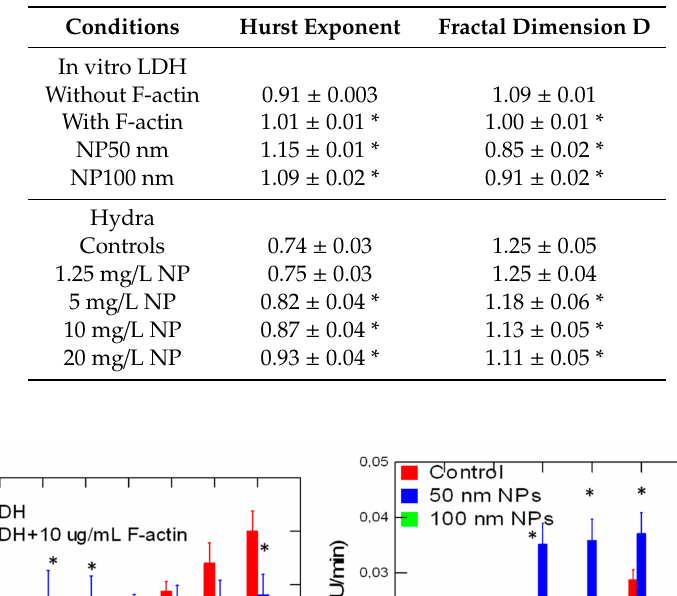
Table 1. Hurst exponent analysis of lactate dehydrogenase (LDH) activity. Hurst exponent H was derived from the relationship: R / S = k (n observation) H . The fractal dimension D was obtained by the following equation D = 2 − H. The star symbol * indicates significance from the proper controls. for N = 3 replicates per treatment.